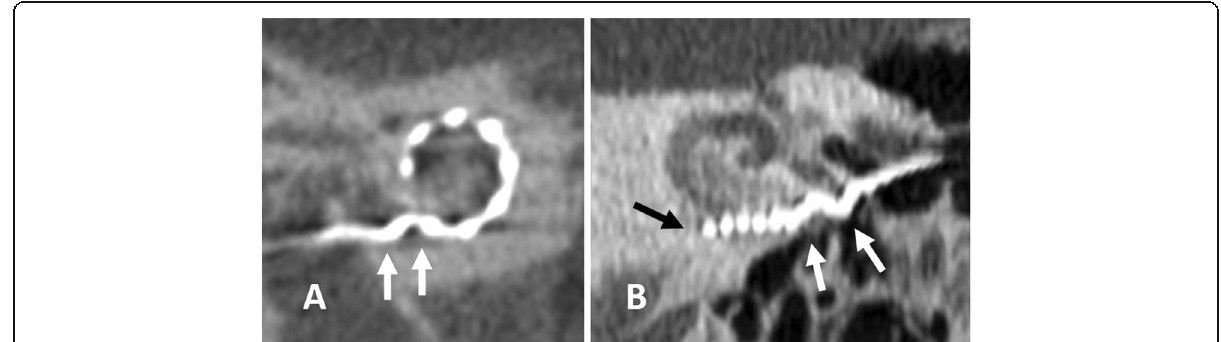
Fig. 28. a A 75-year-old female patient, with electrode bending. CBCT paraaxial image shows electrode bending (arrows) at the basal turn. b A